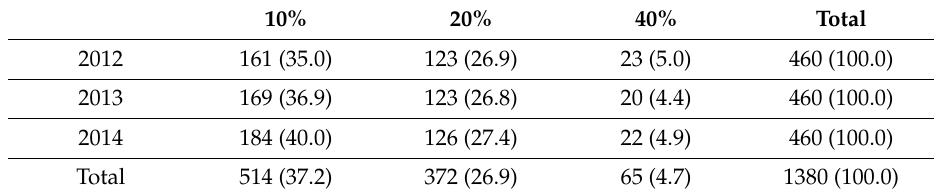
Table 3. Trend of catastrophic health expenditure occurring in cancer households.